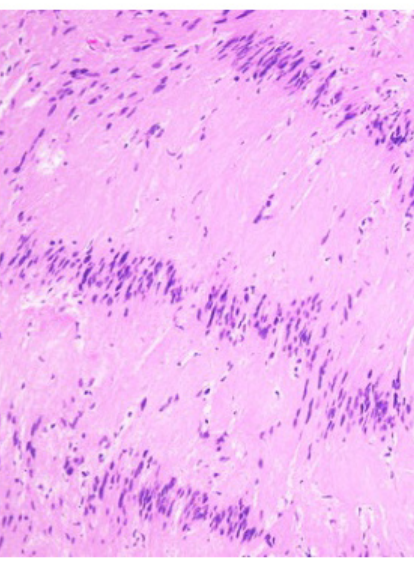
Figure 4. Photomicrograph of tissue taken from the lesion excised from the patient showing cells within Antoni A and Antoni B regions that are characteristic of